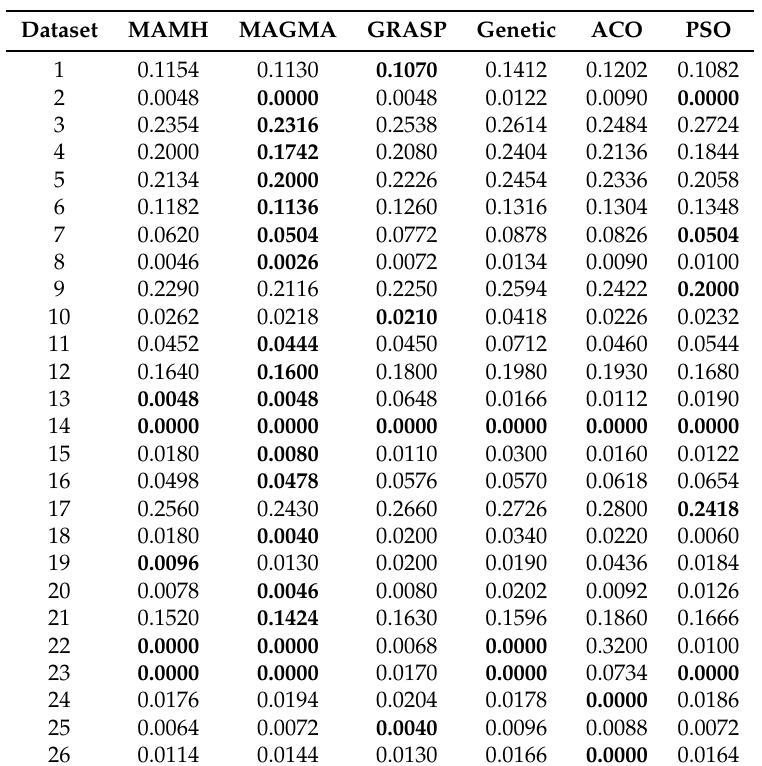
Table 6. The obtained results of all optimization techniques, using the classification error (E) as objective.